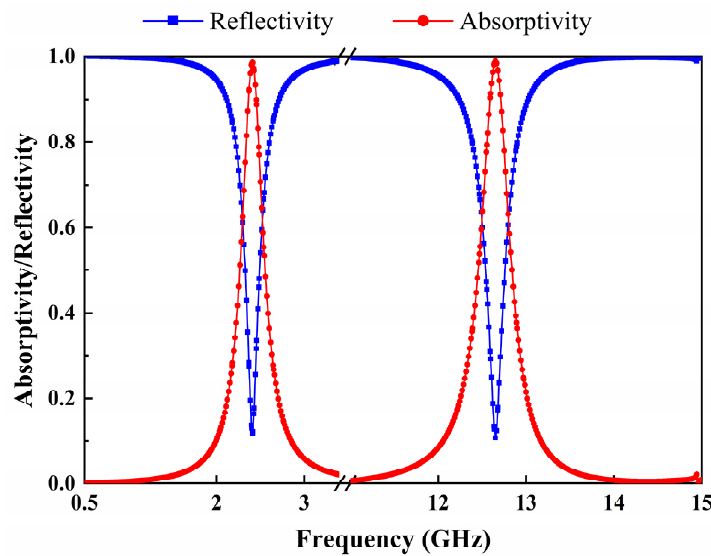
Figure 2. Simulated absorptivity and reflectivity of the metasurface array as a function of frequency.